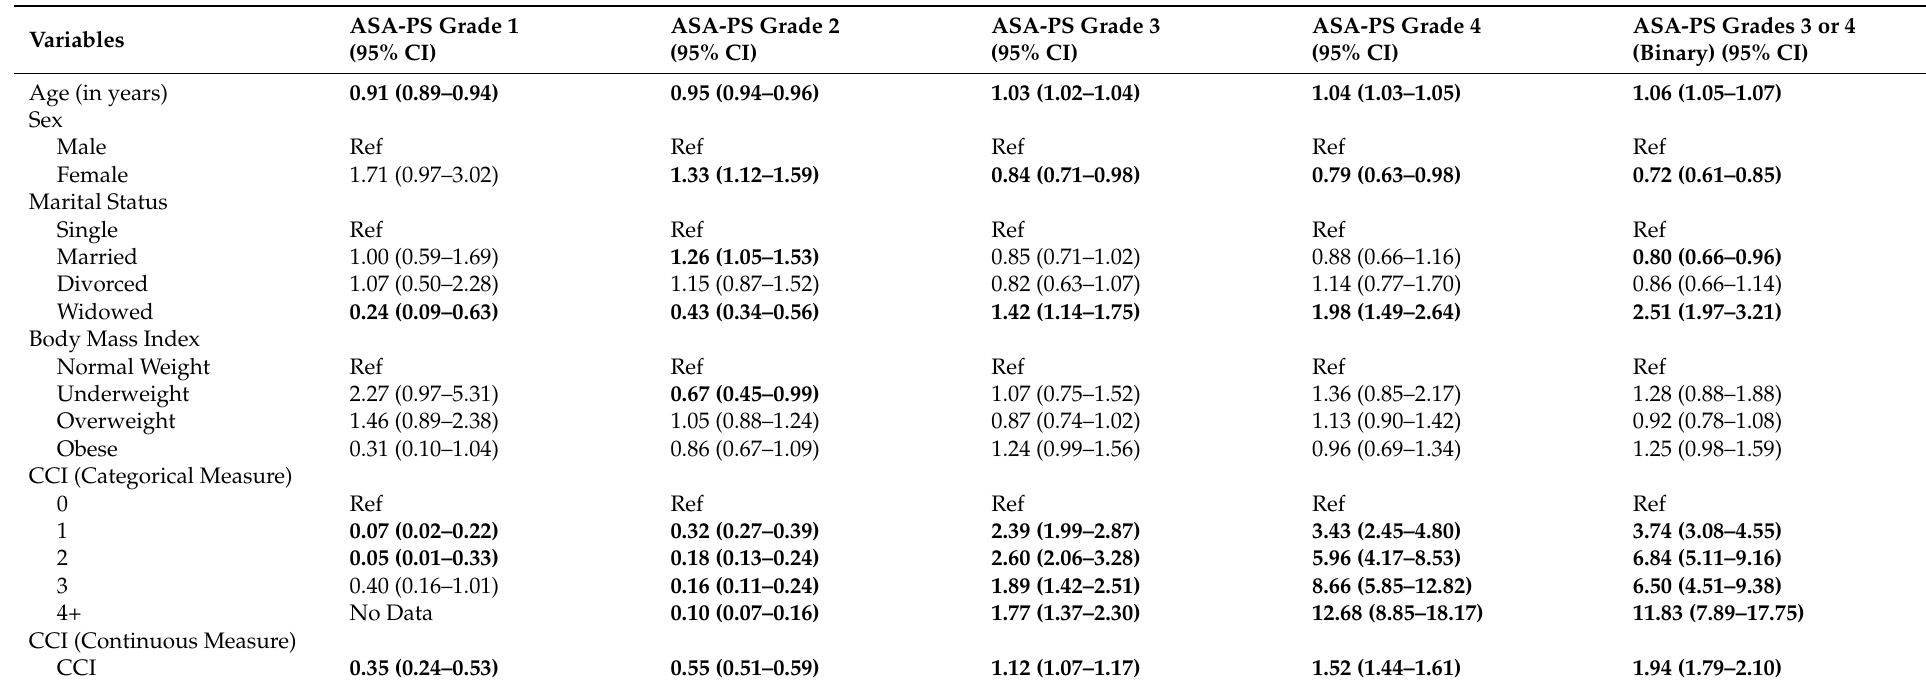
Table 3. Unadjusted odds of demographic characteristics and Charlson Comorbidity Index (CCI) predicting each ASA-PS grade category using the training